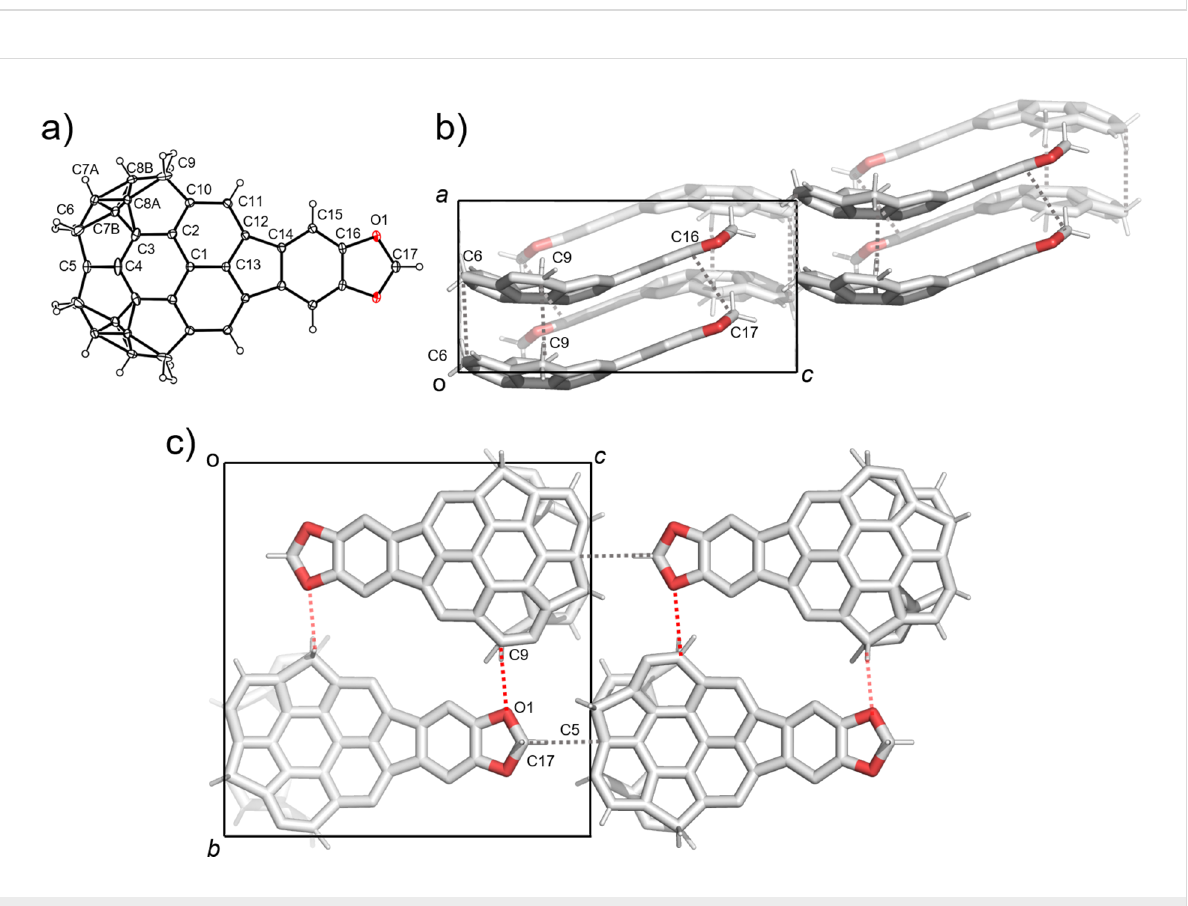
Figure 4: Crystal structure of 5b . a) ORTEP drawing of the crystallographically independent unit with thermal ellipsoid at 50% probability. b) Packing structure viewed from the b axis and c) from the a axis. The dotted lines indicate; grey: CH··· π , red: CH···O interactions. In b) and c), hydrogen atoms which are not engaged in any interactions and the contribution of the one enantiomer are omitted for clarity.